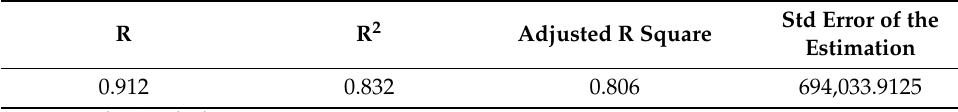
Table 1. Regression summary for the selected variables. R R 2